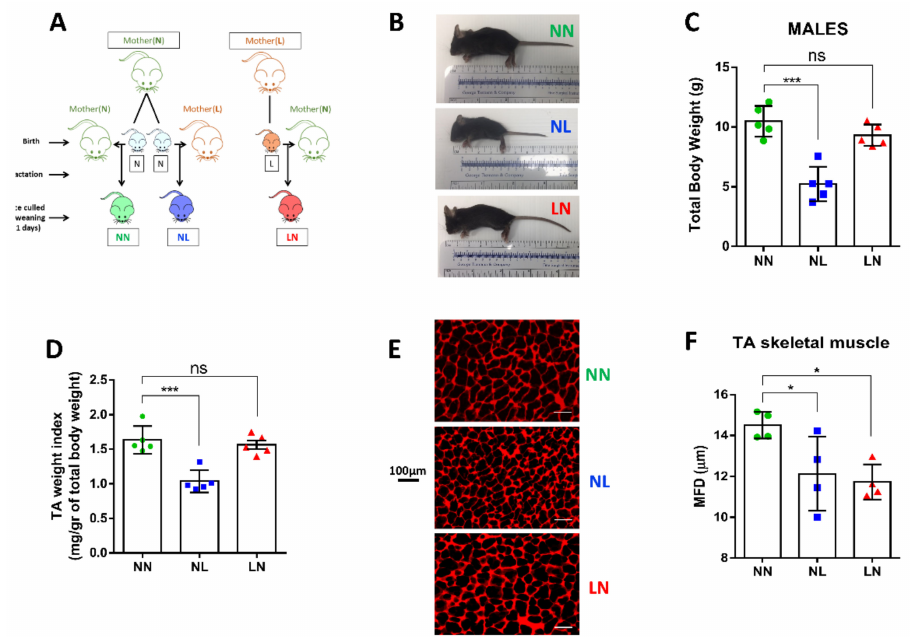
Figure 1. Experimental design and skeletal muscle morphology. Illustrative description of the experimental design of the study ( A ). Male 21d offspring lactated by dams on low protein diet (NL) were smaller in size ( B ) and had lower total body ( C ) and TA muscle/body weight index ( D ) compared to the NN group, while offspring lactated by dams on normal protein diet (LN) did not differ from NN control group. Histological assessment revealed that TA myofibre size was decreased in both NL and LN groups, as shown in representative images ( E ) and measurements of muscle fibre minimum Feret’s diameter (MFD) ( F ). All data are presented as mean ± SD. * p < 0.05, *** p < 0.001, ns, non significant. Scale bar: 100 µ